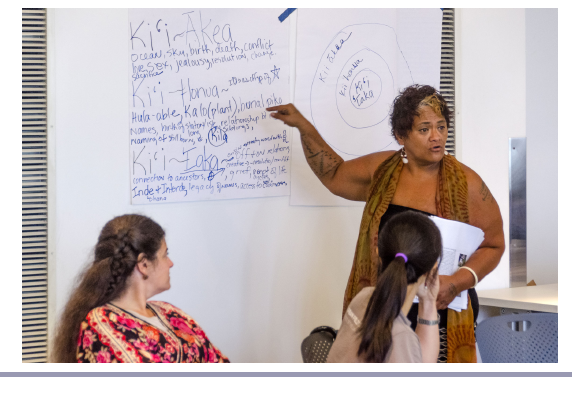
Fig. 2 . Kumu Kekuhi describes the Ki ʻ i framework.